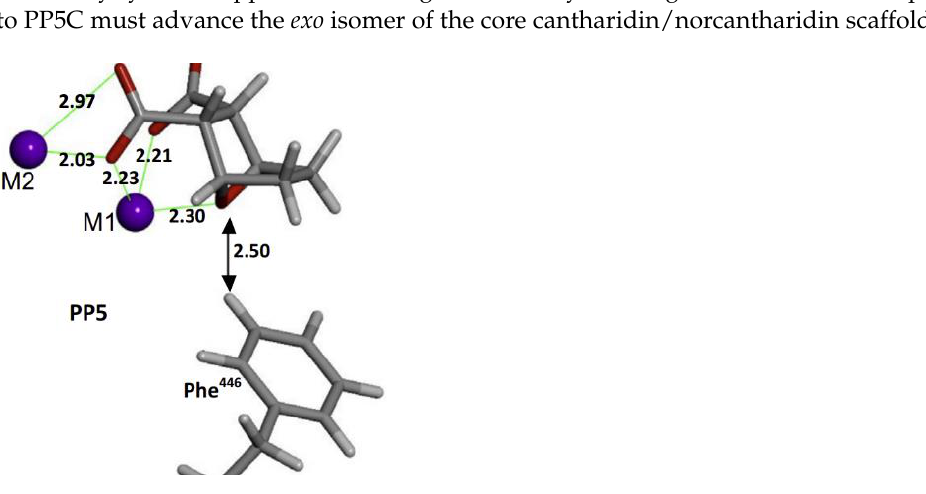
Figure 1. Close-up view of the PP5C complex highlighting interactions between metal ions and the oxygen atoms of endothall, which is hydrolyzed norcantharidin [7].